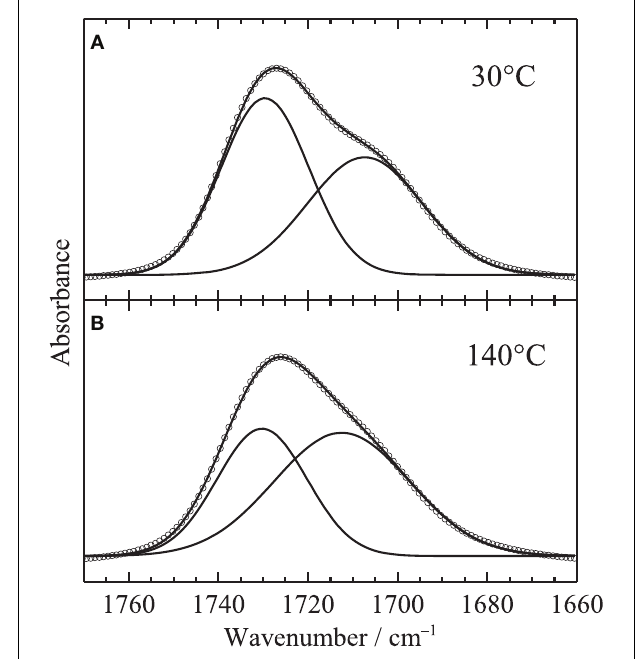
FIGURE 4 | Fitting parameters of (A) peak position, (B) peak height, (C) peak width and (D) area intensity in the O-H stretching region plotted as a function of temperature. Symbols of circle, triangle and diamond correspond to the bands around 3534, 3434, 3320cm − 1 , respectively.